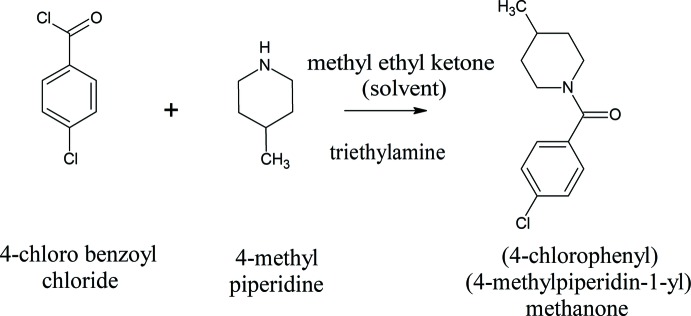
Reaction scheme.